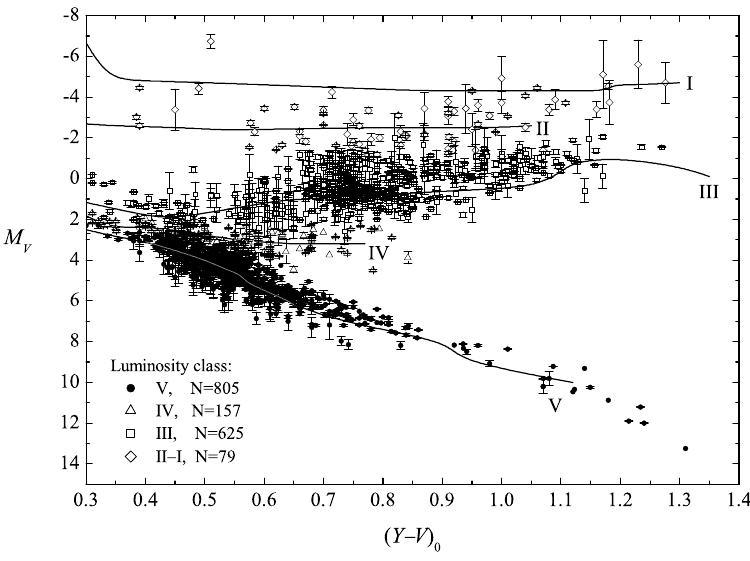
Fig. 1. M V vs. ( Y – V ) 0 diagram for 1666 stars with metallicity estimates from high- dispersion spectra. Absolute magnitudes are calculated from Hipparcos parallaxes, with the exception of 66 stars with unacceptably large parallax errors, mainly of luminosity class III to I, for which M V were derived from Vilnius photometry. The mean relations for solar composition stars of luminosity classes V to I, taken from Straiˇzys (1992), are shown as continuous lines. to authors of [Fe/H] estimates, but only sources after 1990 were used in